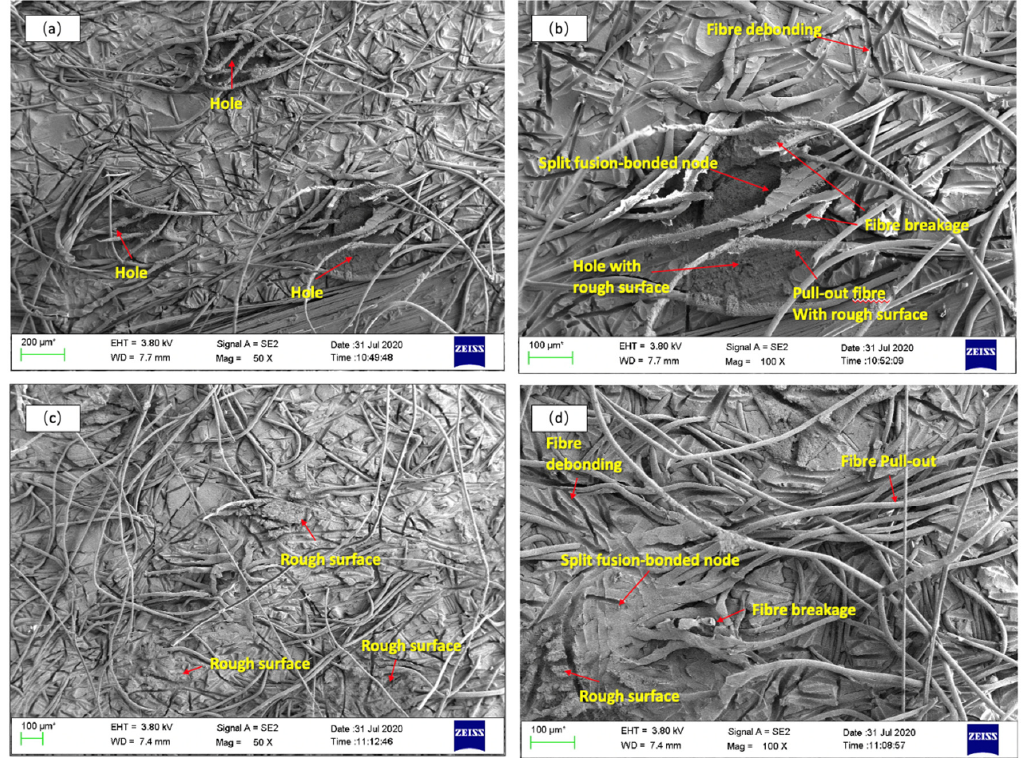
Figure 12. SEM images of fracture surface. ( a , b ) lower surface, ( c , d ) upper surface.